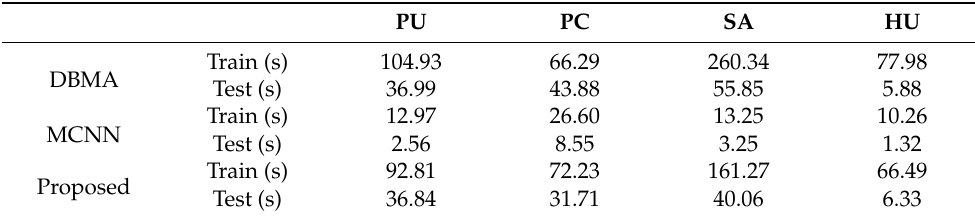
Table 9. Comparison of training and testing times of different attention-based methods on four